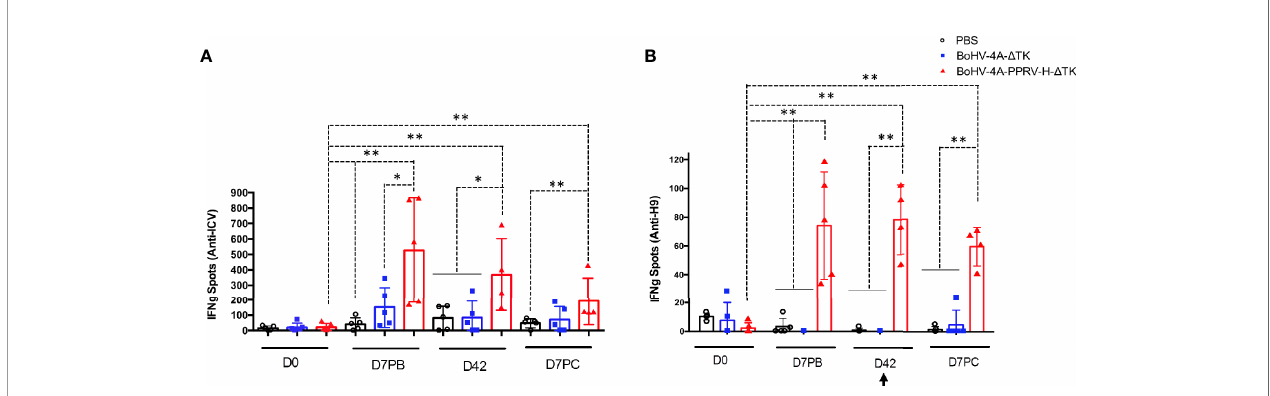
FIGURE 6 | Speci fi c IFN- g production to ICV ’ 89 PPRV strain and H9 peptide in PBMCs from BoHV-4-A-PPRV-H- D TK-inoculated sheep detected by ELISPOT assay. PBMCs from sheep inoculated with PBS (black), control vector (BoHV-4-A- D TK) (blue), or BoHV-4-A-PPRV-H- D TK (red) were isolated at days 0 and 7 post- boost (PB), day 42 post-immunization, and day 7 post-challenge (PC) and cultured for 48 h in the presence of BEI-inactivated ICV ’ 89 PPRV strain virus (A) or H9 peptide from PPRV-H protein (B) . The production of IFN- g was measured using an ELISPOT assay. Data are presented as average (± SEM) IFN- g spots above background for 10 6 cells in each treatment group. A positive control of PBMCs activated with 1.25 m g/ml Con-A (Sigma) was always included to validate the ELISPOT assay. * p < 0.05 and ** p < 0.005 Mann – Whitney test. The black arrow (D42) denotes the time of virulent PPRV ICV ’ 89 challenge in all